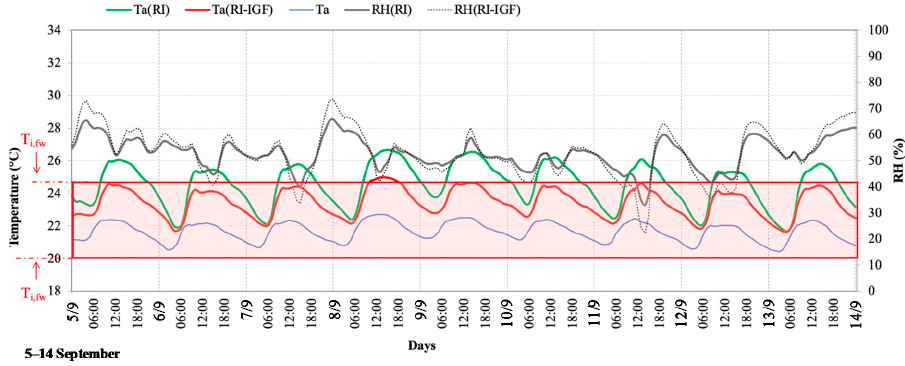
Figure 9. Daily profile of air temperature (T a ) in the current state, after retrofit Ta (RI), and retrofit scenario with no insulated floor on ground surface (RI-IGF) during the period 5–14 September. Table 8. Maximum and minimum values of air temperature, maximum amplitude of temperature, and relative humidity of the three investigated scenarios during the period 5–14 September.